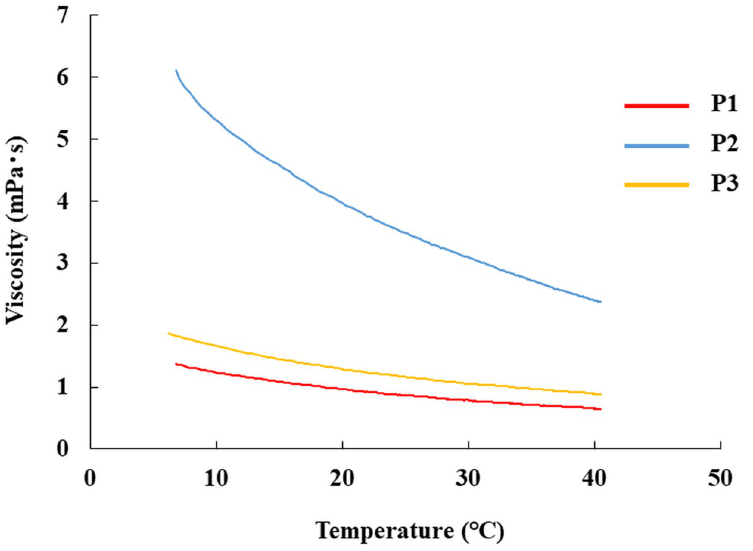
Fig 7. Changes in the viscosity of 0.1% FLU ophthalmic suspensions of each formulation with temperature. The viscosity of the 0.1% FLU ophthalmic suspension in each formulation was measured using a tuning-fork vibration-type viscometer at different temperatures. P1; Original, P2; Generic A, P3; Generic B.